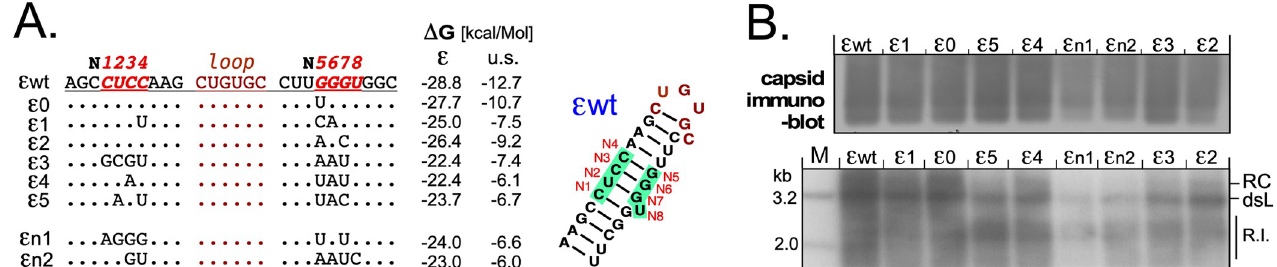
Fig 2. In-cell SELEX derived HBVs with non-wild-type ε are replication competent. (A) Sequences of individual ε variants tested. Randomized positions N1 to N8 (red letters) are depicted in the context of the wt ε upper stem, non-wild-type nt are indicated for each variant. The last columns show the calculated Δ G values (M-FOLD) for the most stable predicted full-length ( ε ) and upper stem (u.s.) structures; for reference, the secondary structure of the wt ε upper stem is also shown. Variant ε 1 combined few mutations (3), good replication competence and reduced Δ G, and was chosen for further experiments. (B) Formation of capsids and replicative DNA intermediates by select variants. Individual HBV plasmids carrying the indicated ε sequences were transfected into Huh7 cells alongside wt HBV vector pCH-9/3091. Four days post transfection, cytoplasmic extracts were analyzed for capsids by NAGE and subsequent immunoblotting ( top ), and for viral DNA from cytoplasmic nucleocapsids by Southern blotting, using a 32 P-HBV DNA probe ( bottom ); R.I., replicative intermediates. The overall patterns were for all variants similar to those from wt HBV, in line with the bulk HBV DNA content of the intracellular capsids, and the appearance of replicative intermediates in extracellular viral particles shown in S3